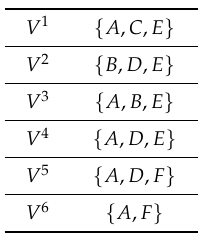
Table 5. Example of set-valued